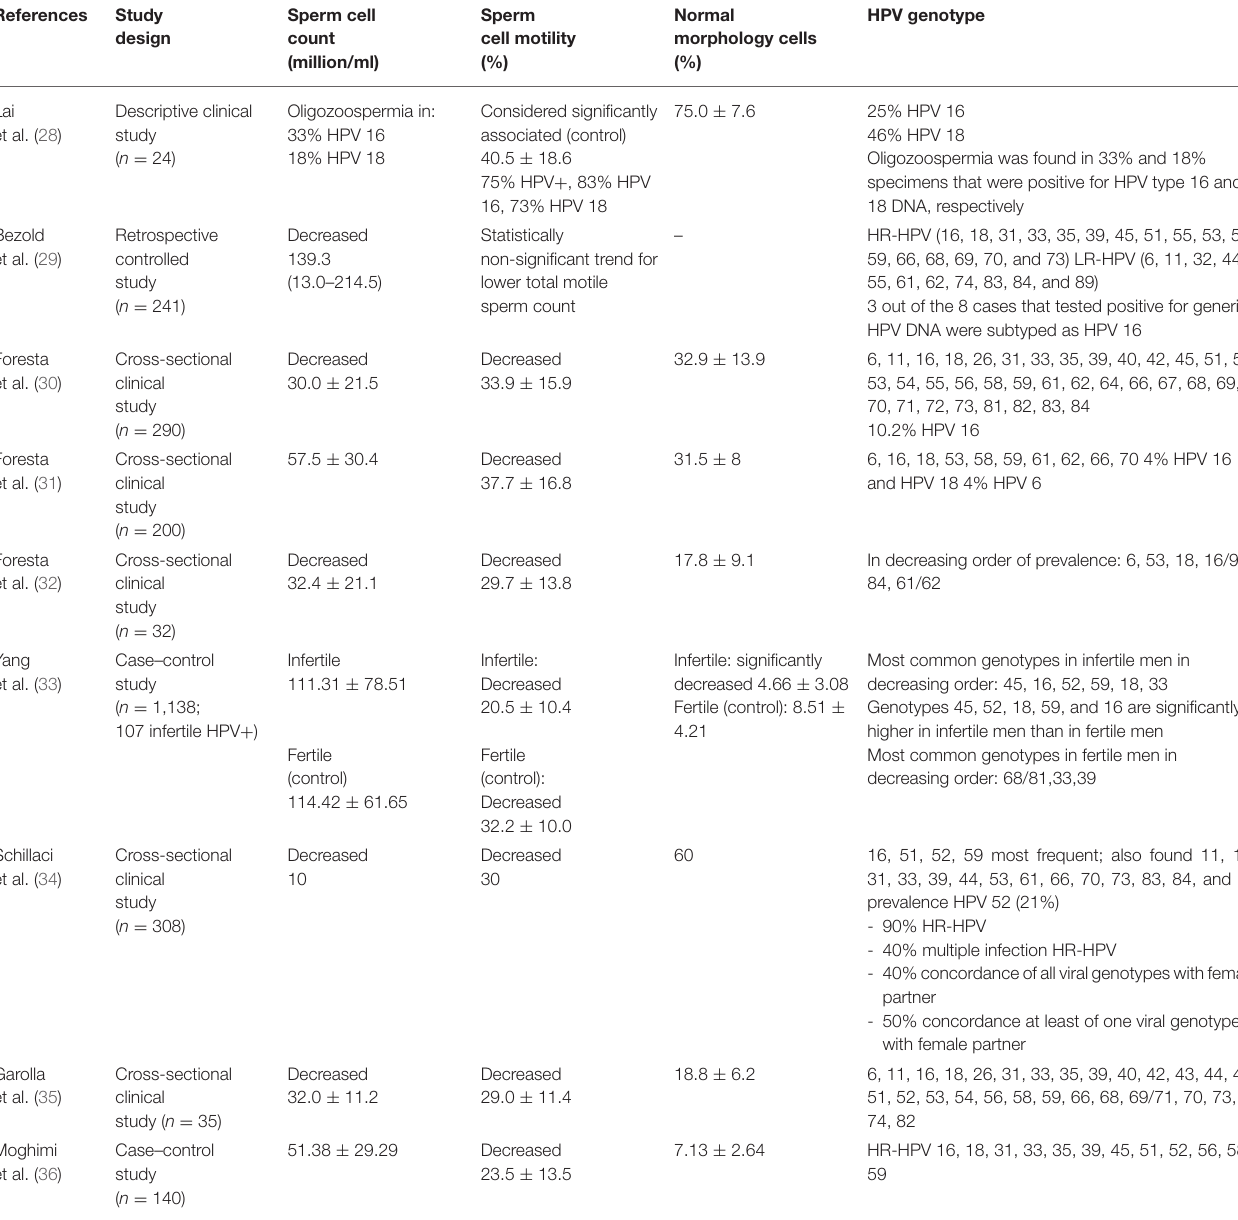
TABLE 2 | Literature regarding the effect of HPV on seminal